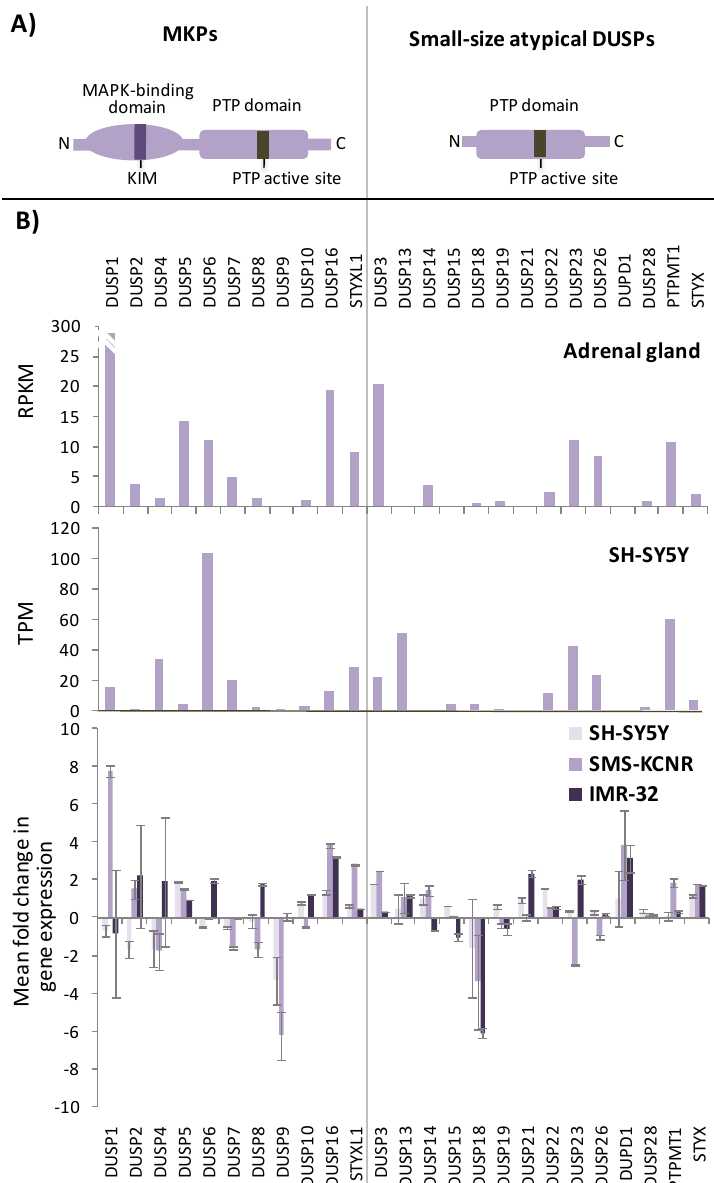
Figure 2. ( A ) Schematic depiction of the domain composition of MKPs and small-atypical DUSPs. KIM—kinase interaction motif; PTP—protein tyrosine phosphatase. ( B ) Upper panel: mRNA expression of MKPs and small-atypical DUSPs in adrenal gland. Data from GTEx (Genotype-Tissue Expression) data sets. RNA-seq data is reported as median RPKM (reads per kilobase per million reads mapped) (https://www.proteinatlas.org/). Middle panel: mRNA expression of MKPs and small-atypical DUSPs in SH-SY5Y human NB cells; data from the Human Protein Atlas. RNA-seq data is reported as median TPM (transcripts per kilobase of exon per million reads) (https://www.proteinatlas.org/). Bottom panel: mRNA expression analysis of MKPs and small-atypical DUSPs from SH-SY5Y, SMS-KCNR, and IMR-32 human NB cell lines treated with retinoic acid (RA). Cell lines were kept untreated or were treated for 10 days with RA, mRNA was extracted and RT-qPCR was performed using a set of MKP and small-atypical DUSP primers, as described in Reference [67]. Relative mRNA expression values are shown in Log 2 as fold change +SD of treated cells versus untreated cells, from at least two independent experiments. Mean fold change above 2 or below − 2 was considered significant. MKP mRNA expression data from bottom panel has been previously published [67].